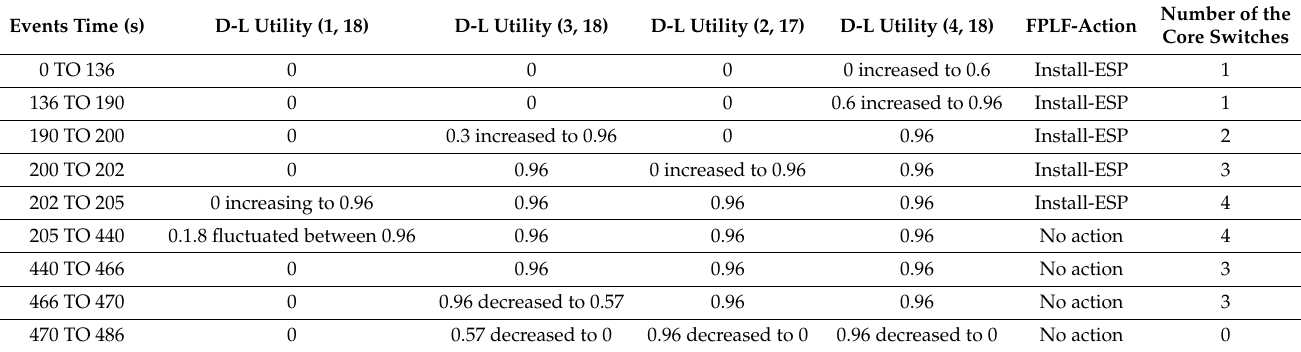
Table 6. High traffic event